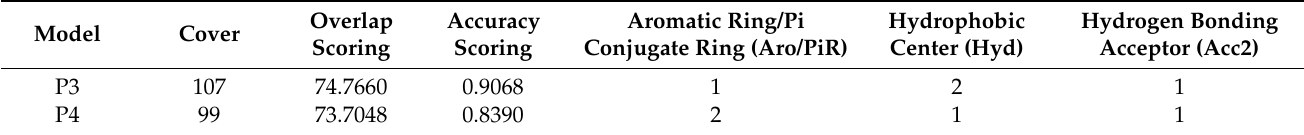
Table 3. Properties of pharmacophore models built from 118 strong